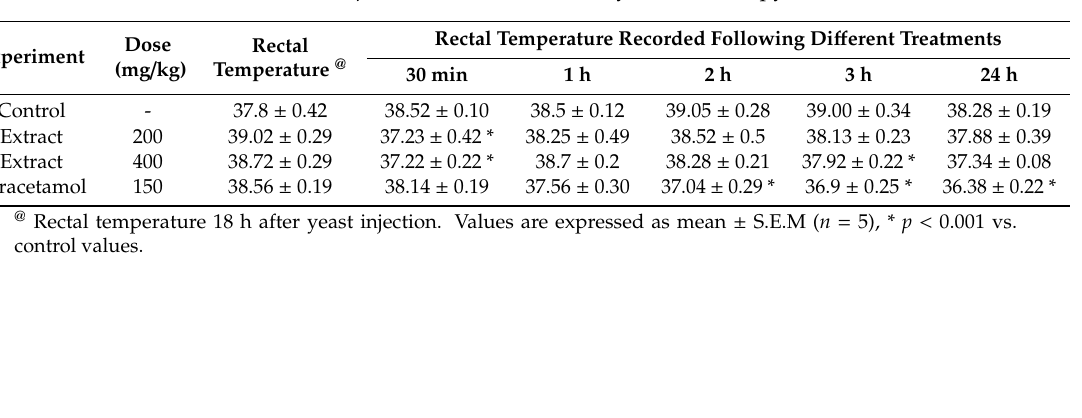
Table 3. E ff ect of S. tetrasperma extract on Brewer’s yeast induced pyrexia in